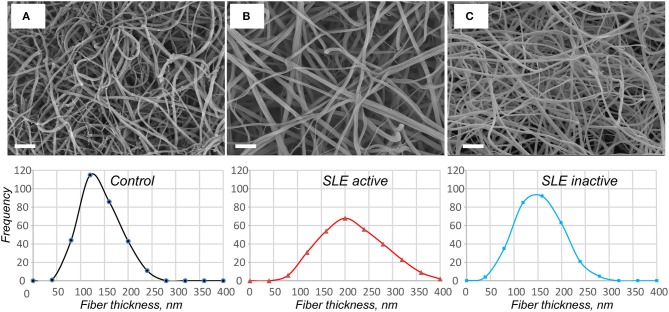
Representative scanning electron micrographs of fibrin clots formed from the control pooled normal plasma (A), active (B), and inactive (C) SLE plasma samples upon re-calcification. The fibrin structure in control and inactive SLE clots is more compact with smaller intrinsic pores. The fibers in active SLE clots are thicker with a reduced number of branch points. Magnification bars = 1 μm. In the lower row the corresponding distributions of fiber thicknesses are presented based on 300 individual fiber measurements (100 × 3 clots) per each experimental condition.